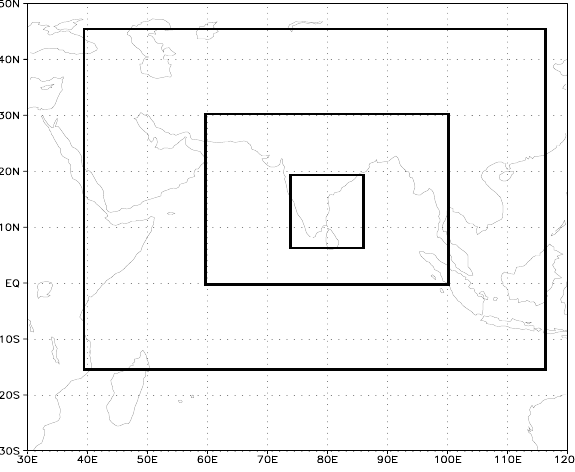
Fig. 1a. Nested model domains used for the simulation of the thun- derstorm. Domain resolution is 32km, 8km and 2km, respectively.